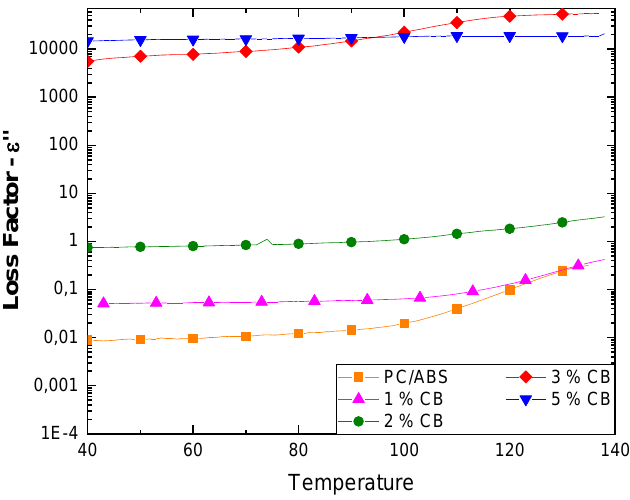
Figure 4. E ff ect of temperature on loss factor of melt blended CB-PC / ABS Figure 4 . Effect of temperature on loss factor of melt blended CB-PC/ABS composites.